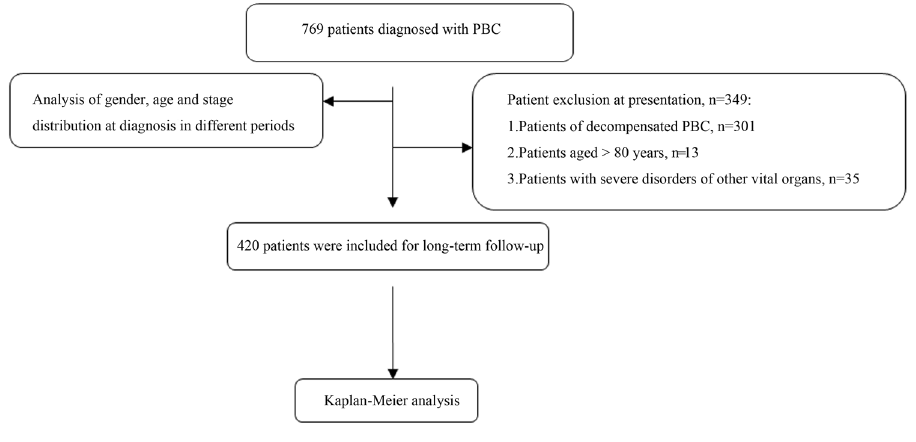
Figure 2. Patient selection flow